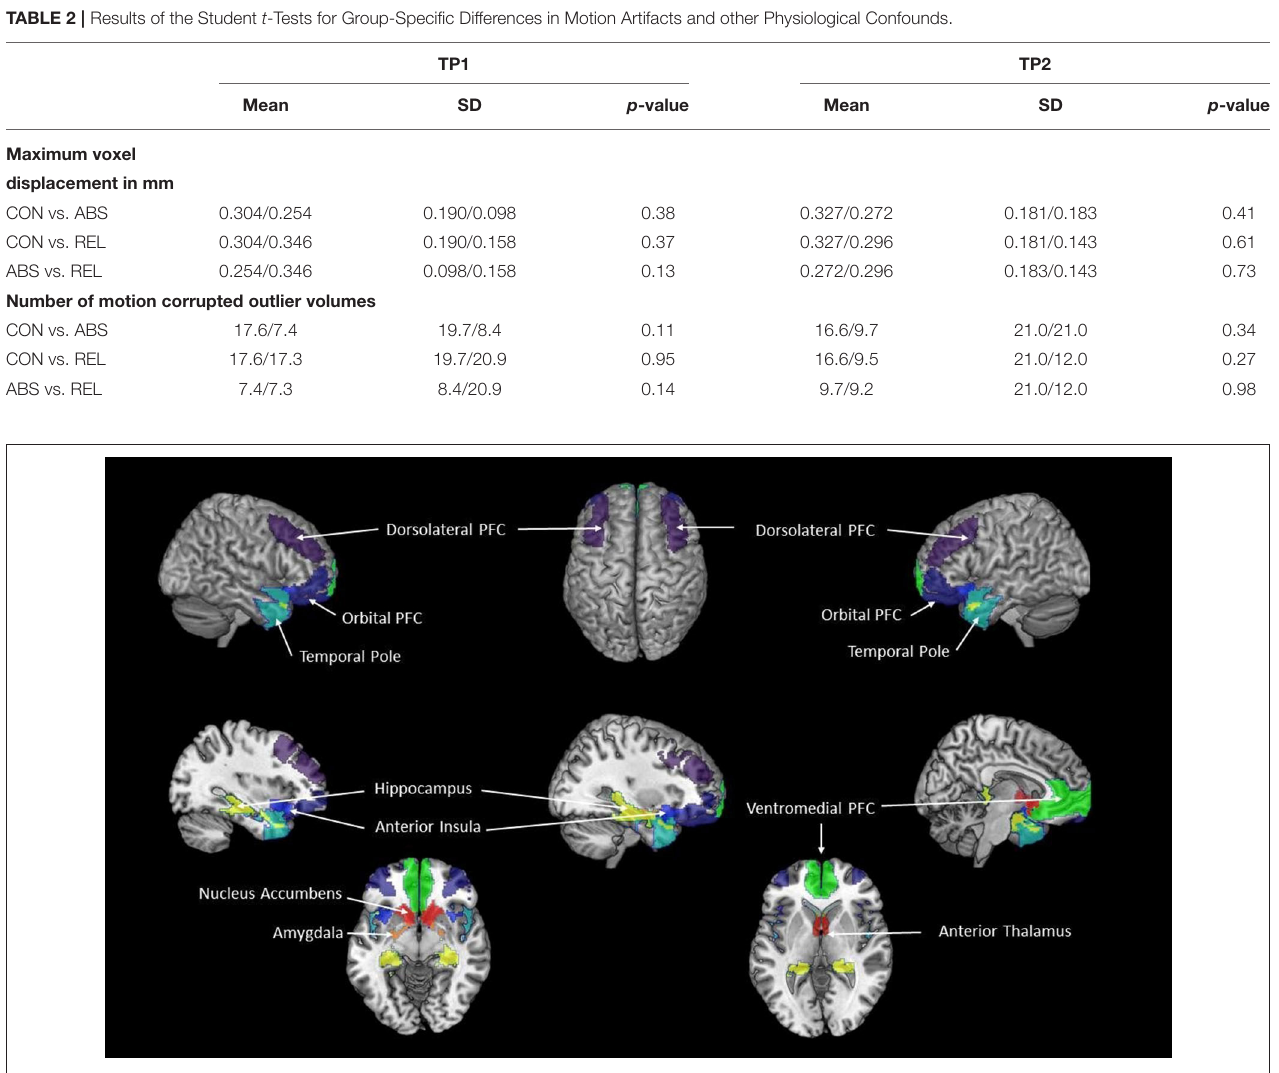
FIGURE 1 | The extended Brain Reward System (eBRS). The nine brain regions of the extended brain reward system–plum = dorsolateral PFC, dark blue = orbital PFC; cyan = temporal pole; pistachio-green = hippocampus; navy-blue = anterior insula; yellow = amygdala; orange-red = nucleus accumbens, dark red = anterior thalamus; lime-green = ventromedial